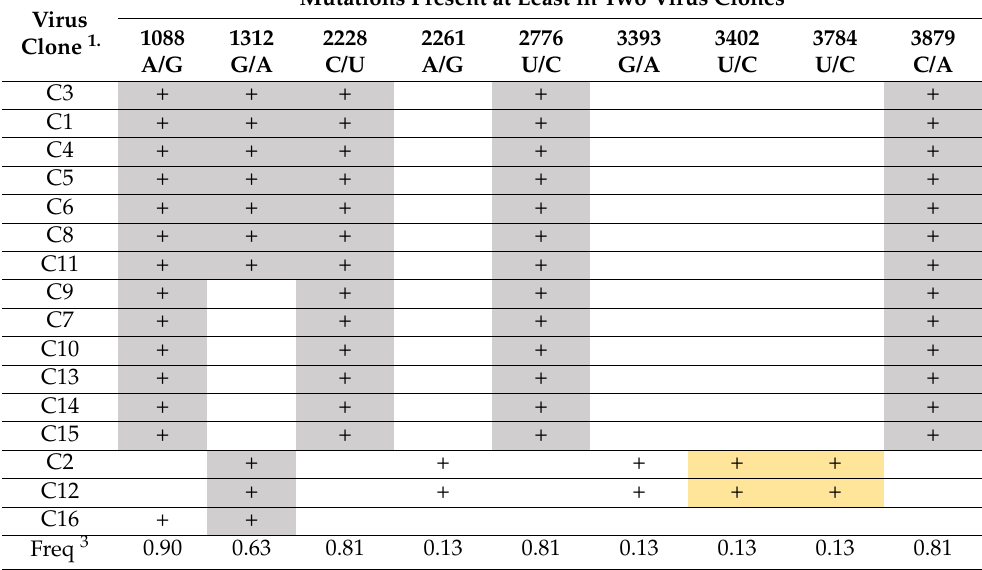
Table 4. Mutations present in the genomic sequences of the virus clones isolated from lineage L2 at transfer